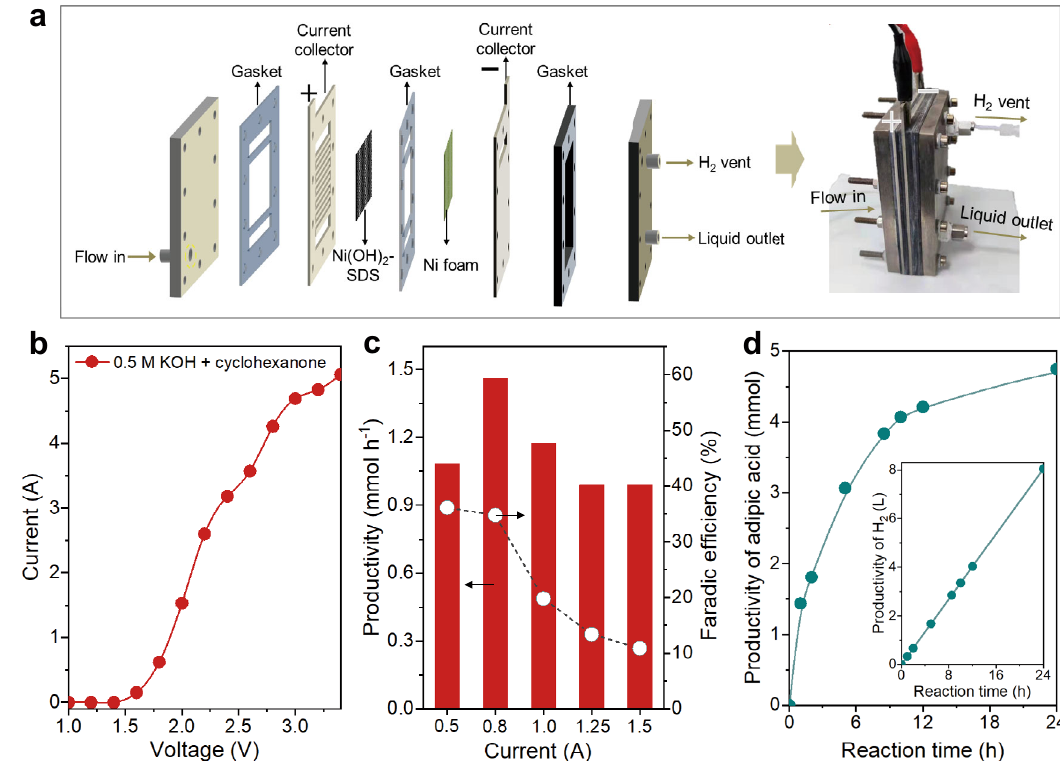
Fig.8|Membrane-free fl owelectrolyzer.a Schematicillustrationandphotograph of the membrane-free fl ow electrolyzer. b LSV curves of Ni(OH) 2 -SDS in the membrane-free fl ow electrolyzer. c Adipic acid productivity and FE at different